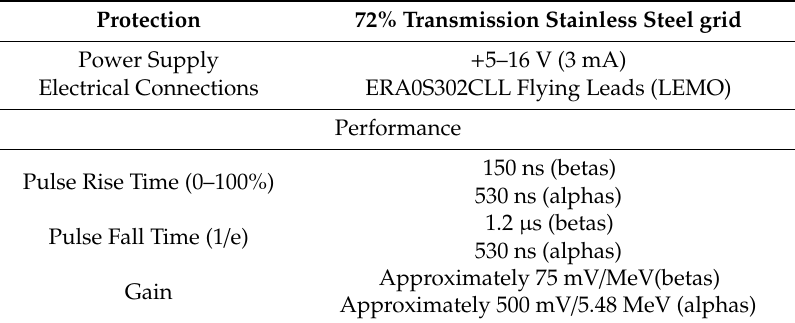
Figure 15. Silicon photomultiplier tube (SiPM) based alpha-beta detector, Scionix: ( a ) α / β detector and ( b ) detector plane [80]. Table 11. Characteristics of Scionix alpha-beta detector.